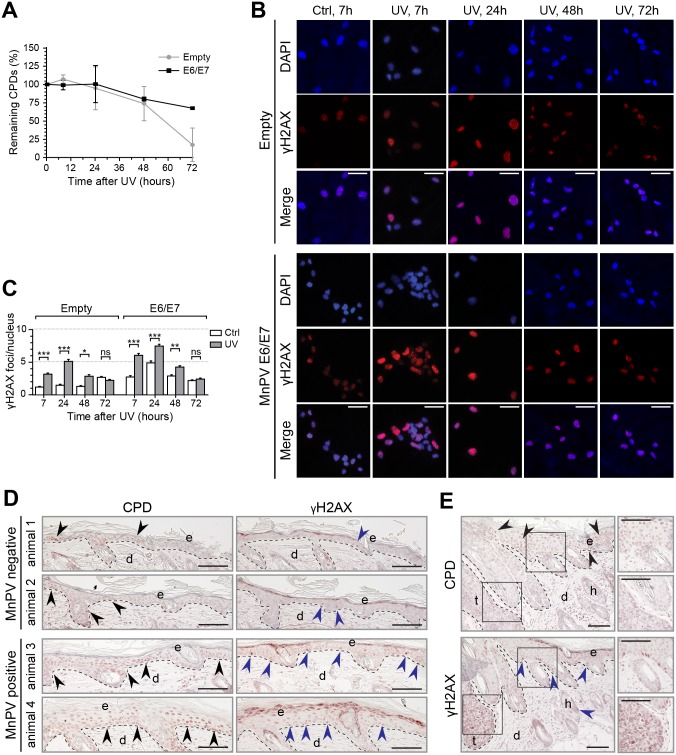
MnPV interferes with DNA damage repair.A) Repair kinetics of CPDs in MnPV E6/E7-positive and -negative Mastomys keratinocytes (Mean ± SD; n = 2, measurements were performed in quadruplicates). B) Immunofluorescence staining of γH2AX foci in keratinocytes stably expressing MnPV E6/E7. Cells were irradiated with UVB and further incubated prior to detection and quantification of γH2AX foci (Ctrl: unirradiated, UV: irradiated; Red: γH2AX, blue: nuclei; scale bars: 50 μm). C) Quantification of γH2AX foci (Mean ± SEM; n≥242; 1way-ANOVA, *p<0.05, **p<0.01, ***p<0.001). D) Co-detection of CPDs and γH2AX in MnPV+/- skin harvested 24h after UV irradiation. Arrows point towards positive cells (Viral loads: animal 3: 13.68 ± 1.66 copies/cell, animal 4: 147.42 ± 14.62 copies/cell; Scale bars: 100 μm). E) Co-detection of CPDs and γH2AX in a KSCC harvested 24h after UV irradiation (Viral load: 611.88 ± 18.75 copies/cell; scale bars: 100 μm).